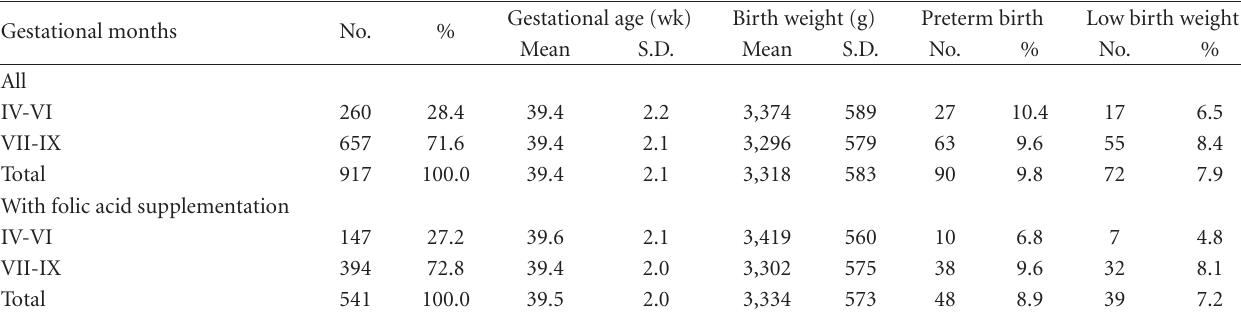
Table 4: The e ff ect of folic acid for birth outcomes of pregnant women with early and late onset